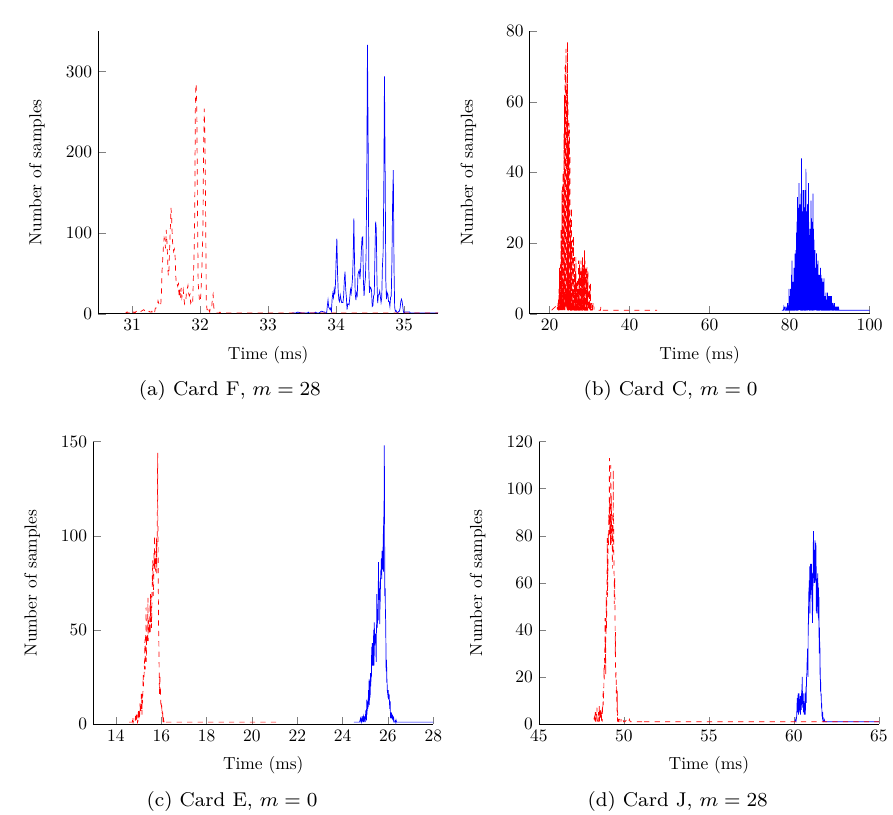
Figure 2: Distribution of the number of cases when the padding data is valid ( D R , continuous blue line) and when it is invalid ( D W , dashed red line) with respect to the response time. The command’s data field carries m +2 encrypted blocks (including padding data), and the 8-byte MAC